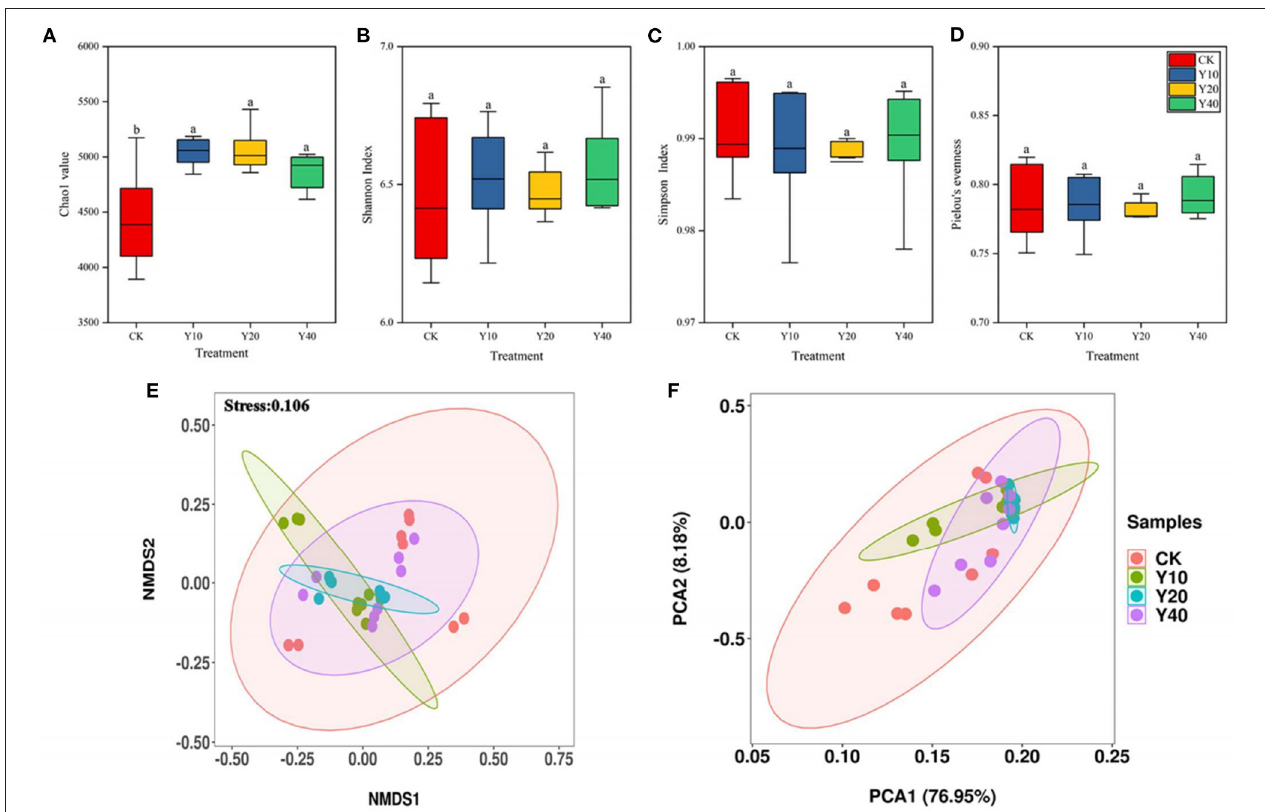
FIGURE 1 | Alpha diversity of 16S rRNA gene sequencing data among groups CK, Y10, Y20 and Y40. (A) Chao1 value, (B) Shannon Index, (C) Simpson Index, (D) Pielou’s evenness. Results are means of eight replicates. Different letter means the significant difference ( P < 0.05). The non-metric multidimensional scaling (NMDS) (E) and principal component analysis (PCA) (F) plots of soil bacterial community beta diversity.